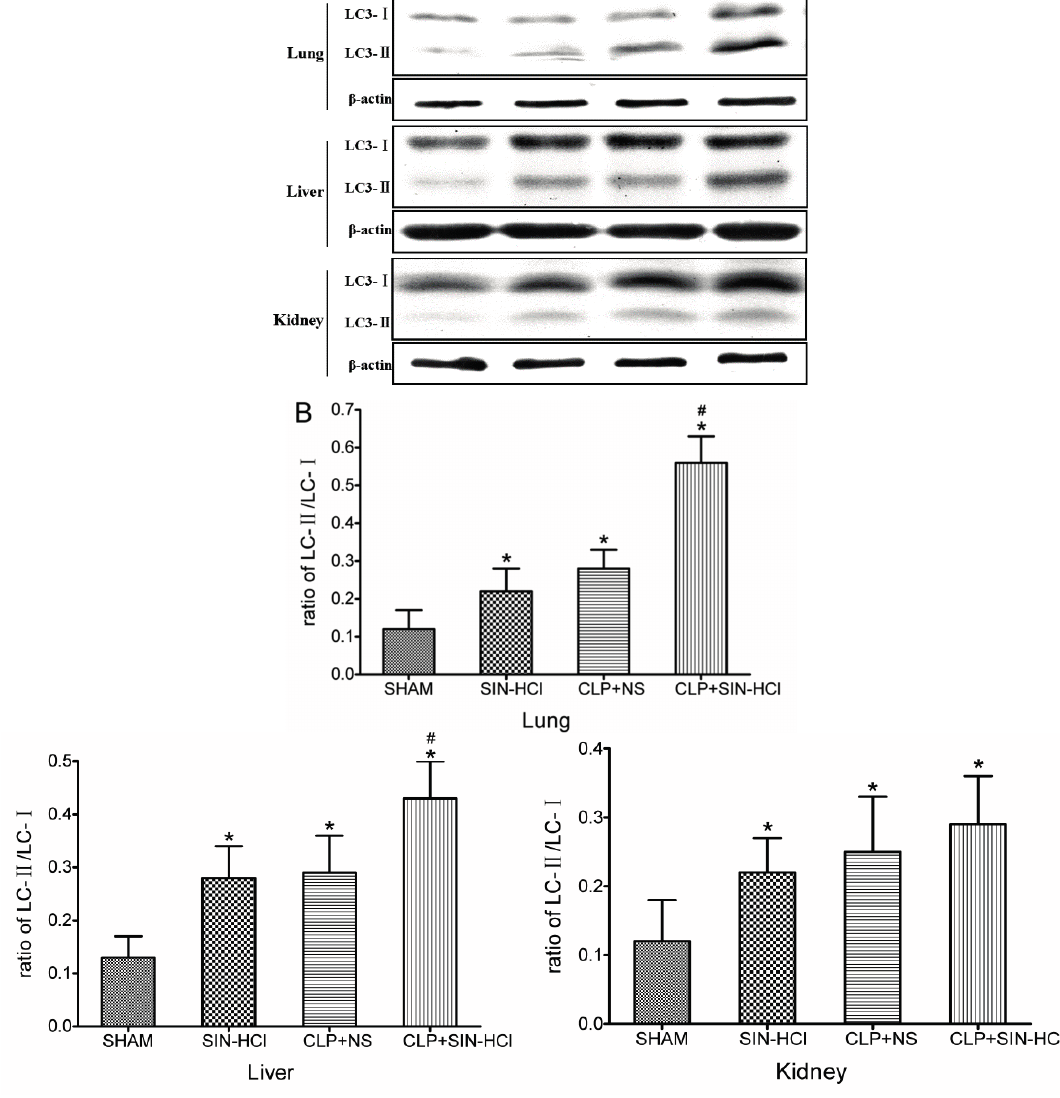
Figure 3. CLP-induced autophagy in multiple organs was strengthened in SIN-HCl-treated mice. ( A ) SIN-HCl treatment strengthened CLP-induced autophagy in multiple organs of the mice. The protein level of LC3 was measured using an anti-LC3 antibody. The ratios of LC3-II:LC3-I in the lungs, liver, and kidneys were higher at 12 h after CLP procedure or SIN-HCl treatment. SIN-HCl further increased the ratios of LC3-II:LC3-I in the lungs and livers of mice that had undergone the CLP; ( B ) Western blotting was quantitatively analyzed, * p < 0.05 when compared with sham BALB/c mice, n ≥ 5; # p < 0.05 when compared with the CLP + NS-treated BALB/c mice, n ≥